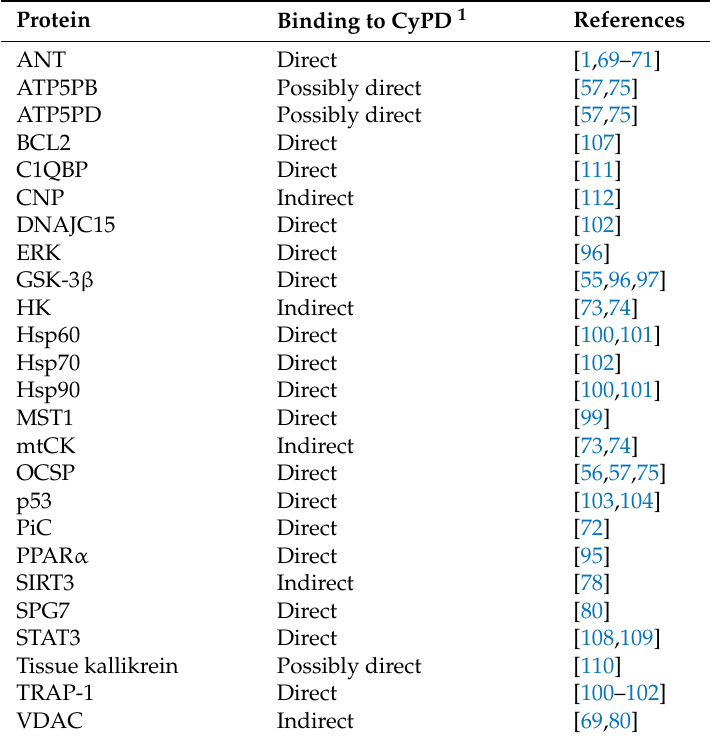
Table 2. CyPD binding